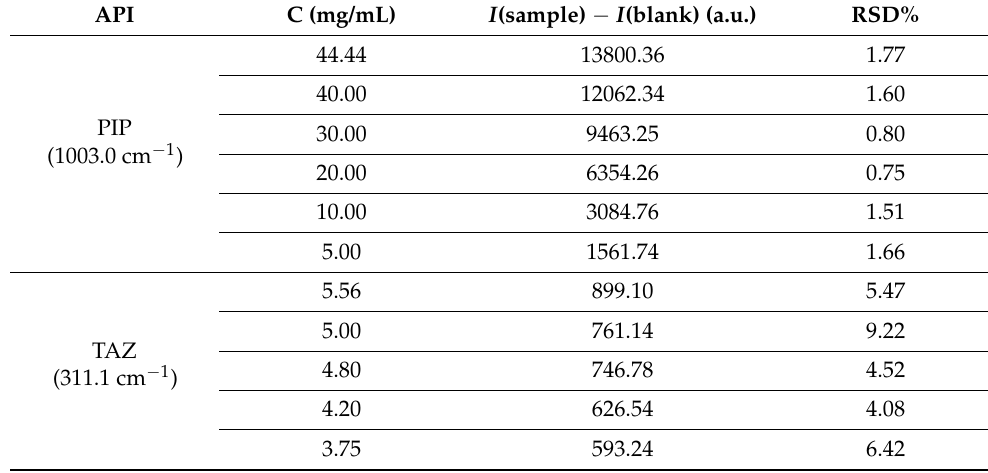
Table 6. Mean peak height values I1003(sample) − I1003(blank) and I311(sample) − I311(blank) and re- spective relative standard deviation (RSD) values corresponding to the three measurements obtained from the samples after they had been placed in the Raman optic cell.